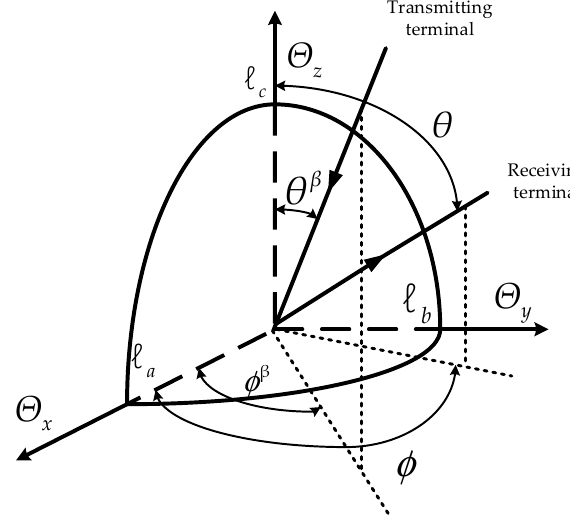
Figure 2. Scattering model of the ellipsoid.